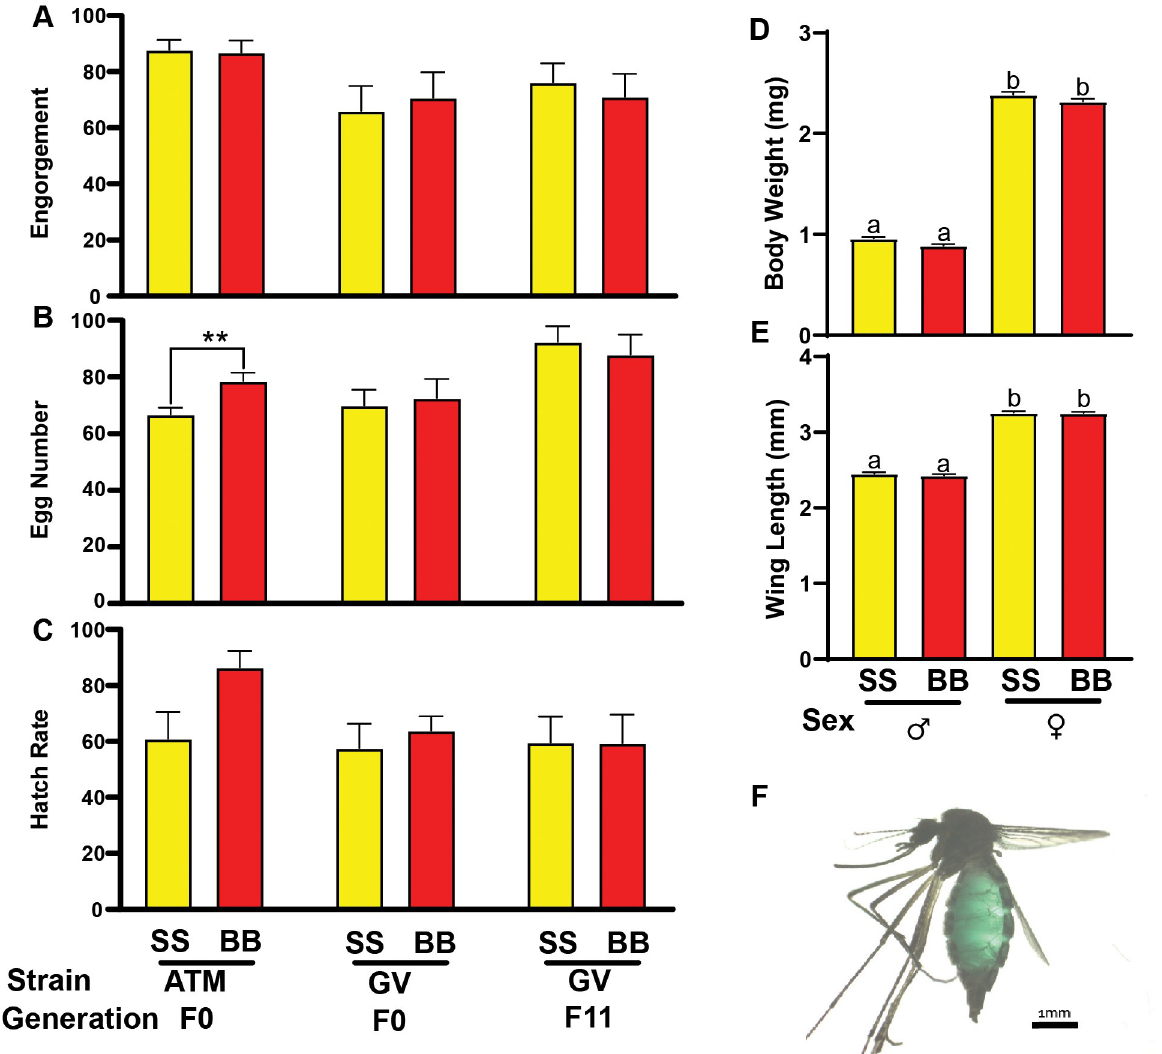
Fig 2. Female reproductive performance after feeding SkitoSnack or bovine blood to Aedes albopictus . – (A) Percent engorgement on SkitoSnack (SS) and bovine blood (BB) in different strains. A Kruskal -Wallis H test showed that there was not a statistically significant difference in engorgement rate between treatment groups, (H = 8.69, p = 0.1221) (B) Average number of eggs laid per individual female comparison between SkitoSnack and bovine blood in different strains. (C) Egg hatch rate comparison between SkitoSnack and bovine blood in different strains. (D) The average weight comparison between 11 th generation bovine blood and SkitoSnack-raised mosquitoes. Different letters indicate significant difference at P < 0.05. (E) The average wing length comparison between 11 th generation bovine blood and SkitoSnack raised mosquitoes. Different letters indicate significant difference at P < 0.05. (F) Ae . albopictus engorged on a SkitoSnack, the green color is due to the added food color in the meal.